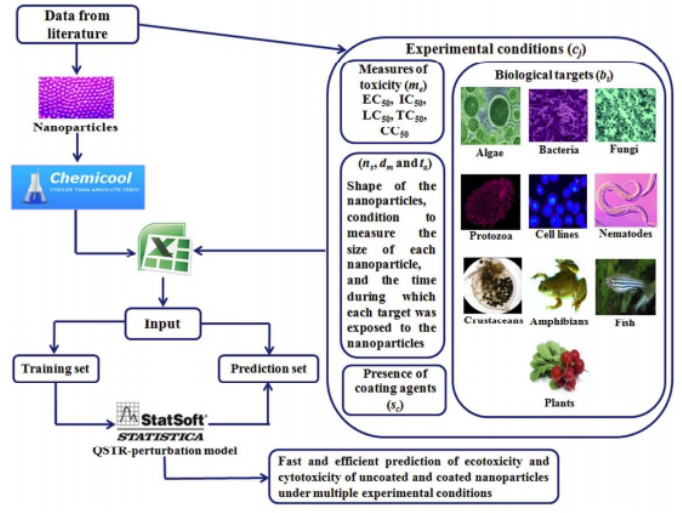
Fig. 4. The main steps in developing the QSAR-perturbation